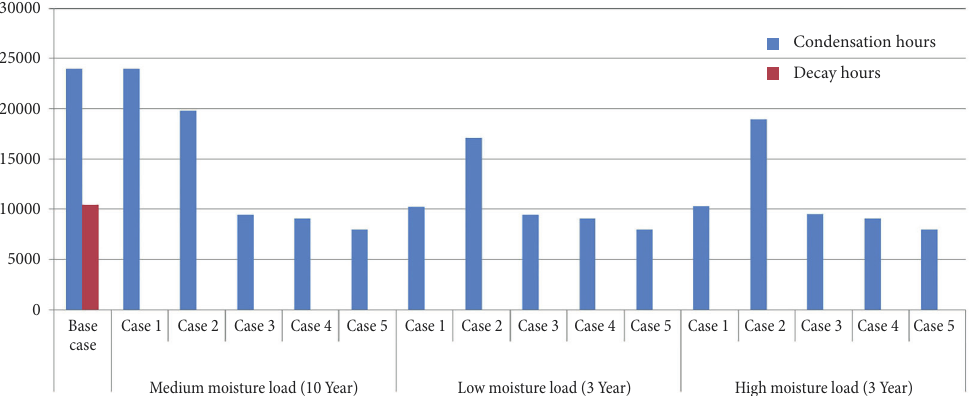
Fig. 4. Condensation and decay hours for installation Method